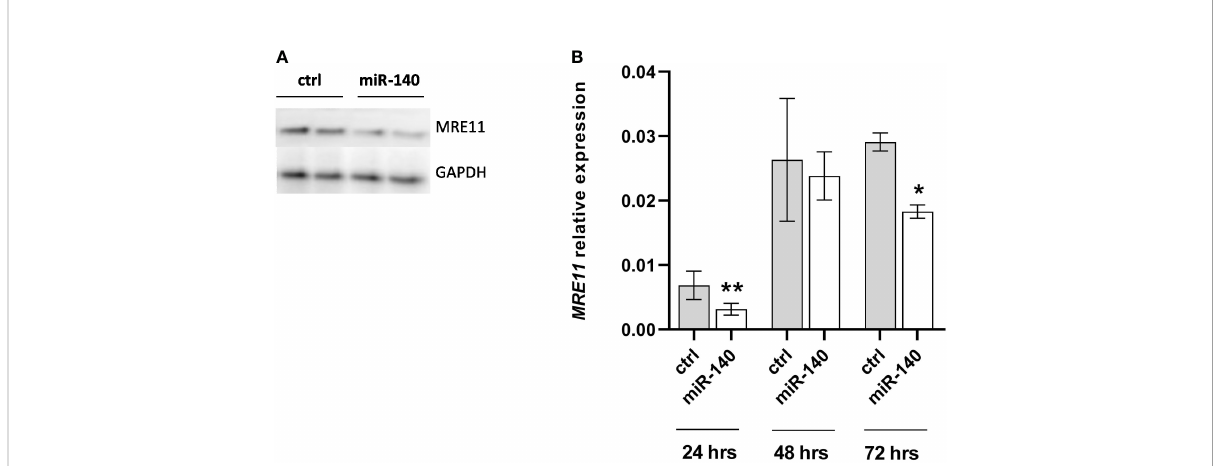
FIGURE 3 Increased levels of miR-140 led to the downregulation of MRE11. (A) Western blotting analysis of cells after transient transfection of miR-140 in the DLD1 cell line showed decreased protein level of MRE11. (B) qPCR analysis of cells showed decreased MRE11 mRNA level. The results